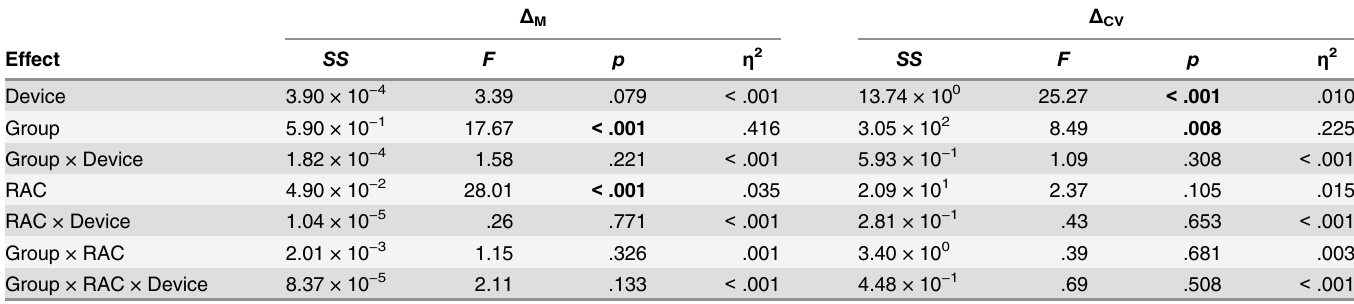
Table 4. Statistics associated with the Group × RAC × Device ANOVA for step length outcome measures.